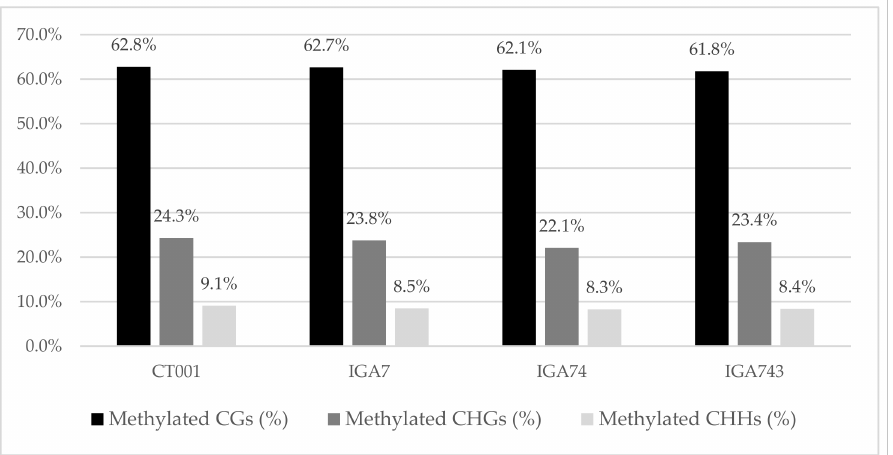
Figure 1. Methylation rates of the non-transgenic and transgenic lines. Proportions of methylated cytosines in the 3 contexts ( m Cs ≥ 3), classified as CG, CHG, and CHH (H indicates A, C, or